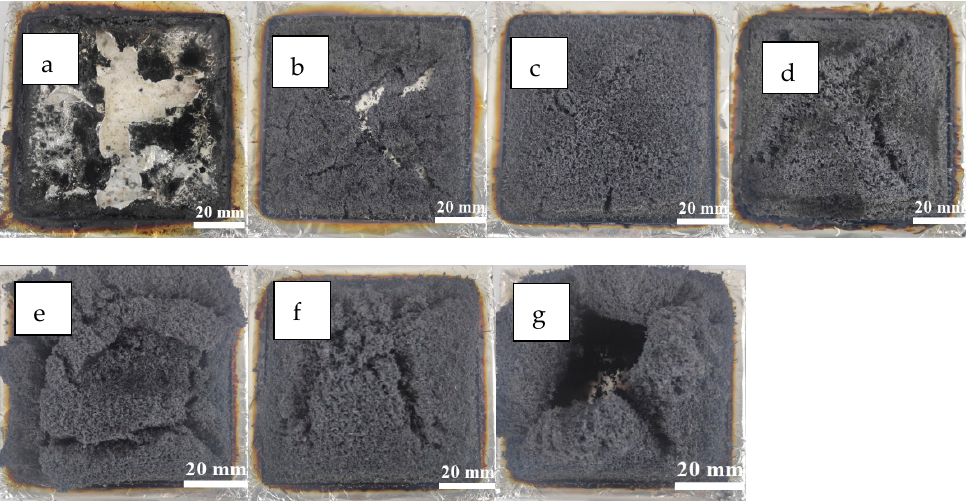
Figure 14. Digital photographs for the residues after cone calorimeter test: ( a ) MPUE, ( b ) MPUE/EG-5, ( c ) MPUE/EG-10, ( d ) MPUE/EG-15, ( e ) MPUE/EG-20, ( f ) MPUE/EG-25, and ( g ) MPUE/EG-30.